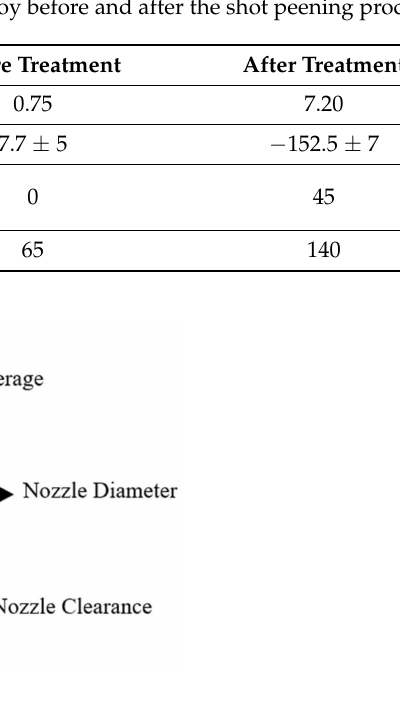
Table 2. Surface integrity variation of aluminum alloy before and after the shot peening process.